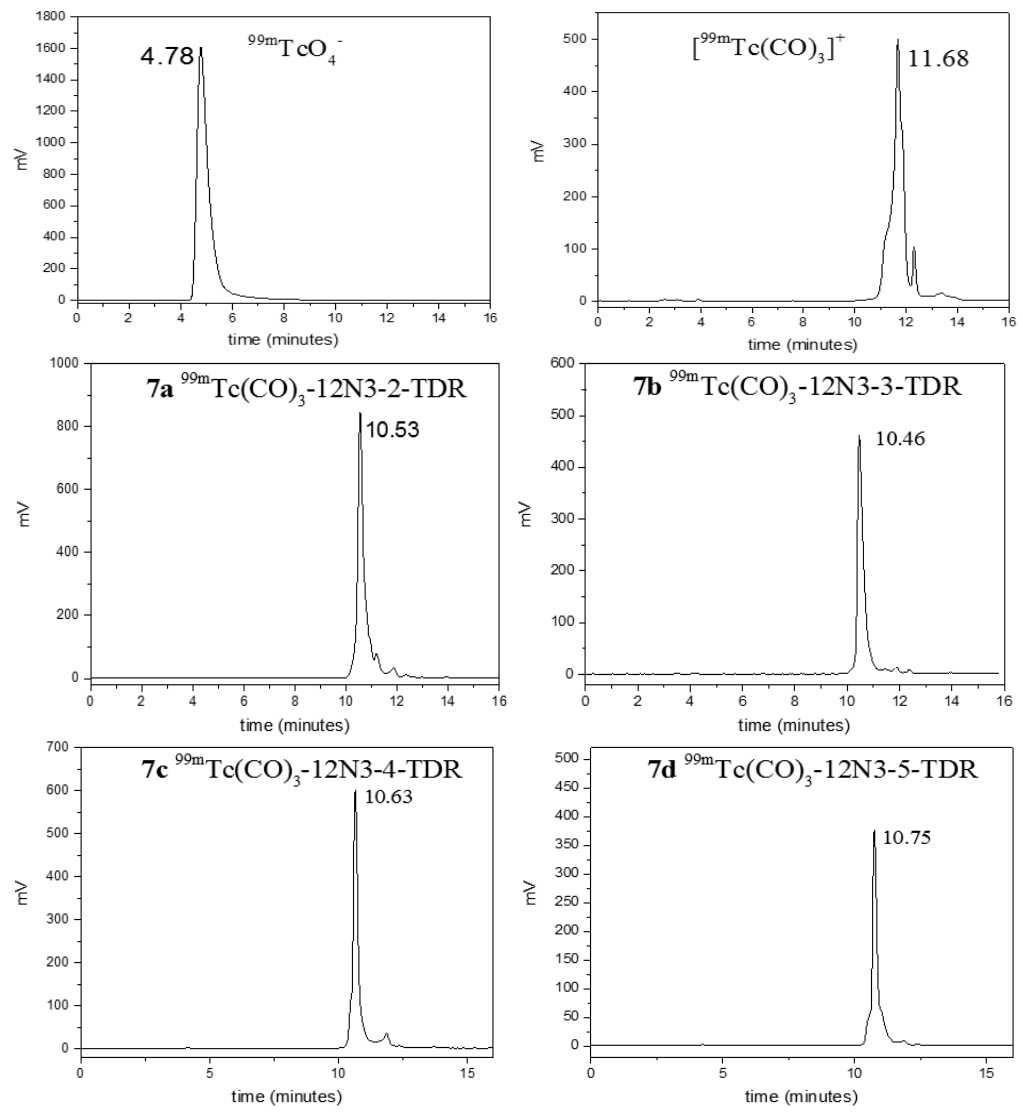
Figure 1. HPLC chromatograms of 99m TcO 4 − (t R = 4.78 min), [ 99m Tc(CO) 3 ] + (t R = 11.68 min), 7a (t R = 10.53 min), 7b (t R =10.46 min), 7c (t R = 10.63 min) and 7d (t R = 10.75 min).